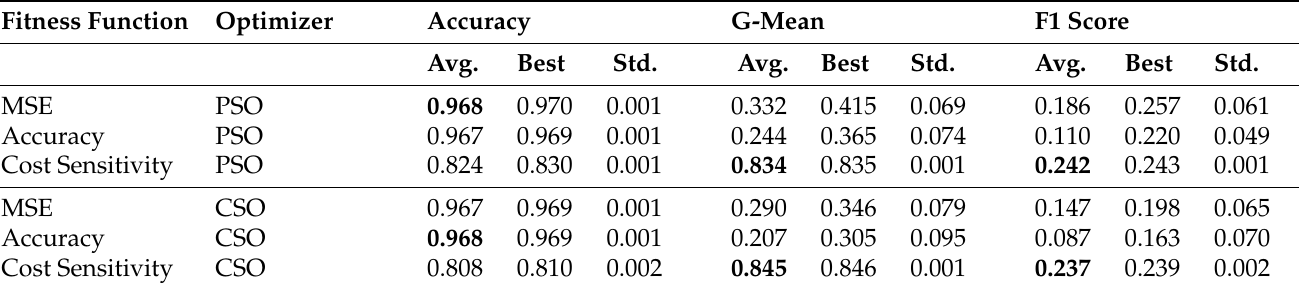
Table 9. The results of the evaluation metrics for all of the fitness functions that were applied to the dataset of Taiwanese companies per optimization algorithm. The best average result for each metric is marked in boldface.